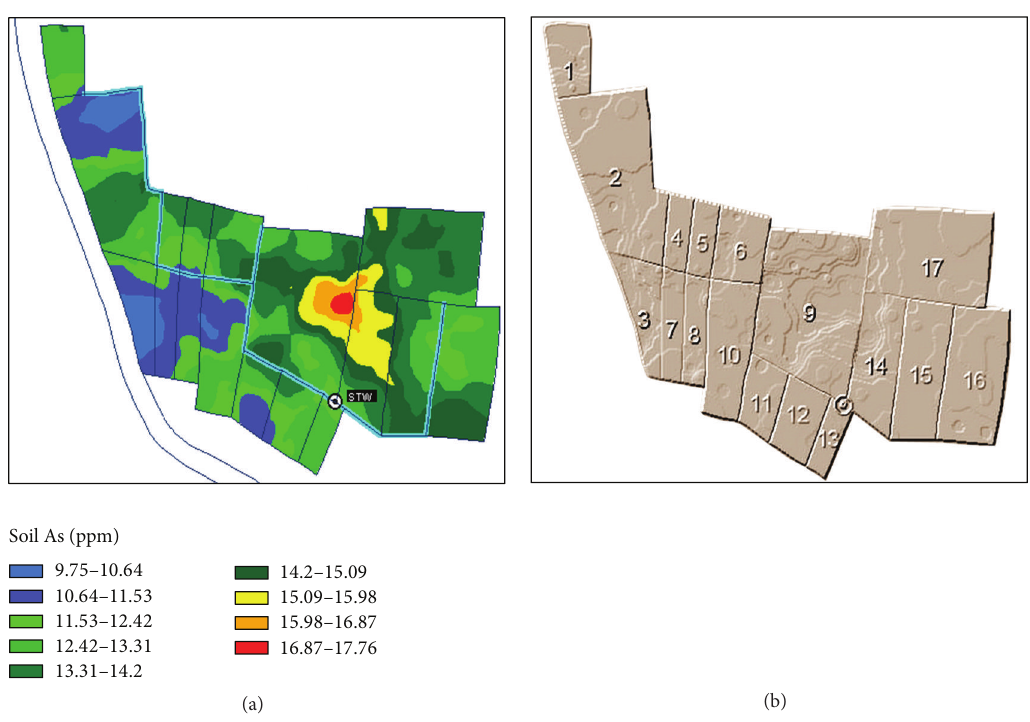
Figure 9: (a) Comparison of soil As surface and elevation model (the number 1, 2, .. . in (b) represents plot number).